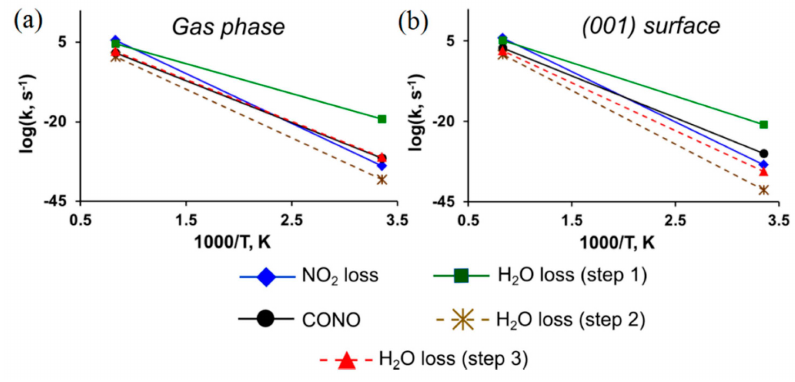
Figure 13. Reaction rates of TATB decomposition ( a ) in the gaseous phase and ( b ) on the (001)